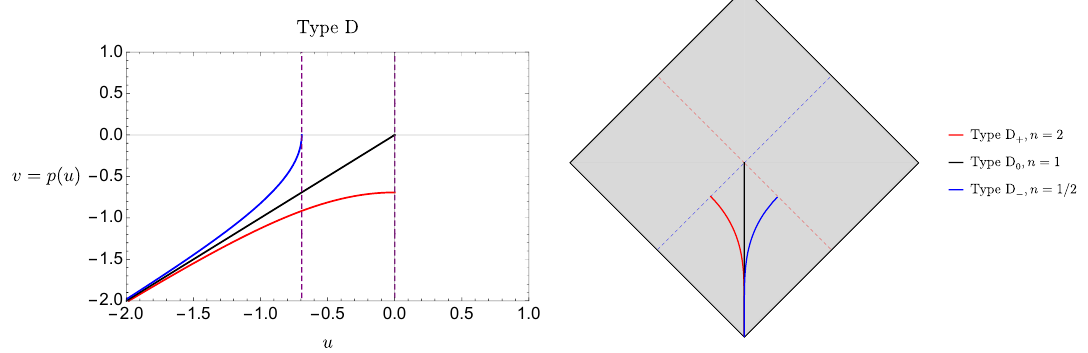
Figure 8 . Type D mirrors. The three types D + , D 0 , and D − are distinguished in table 3. Left: corresponding conformal mapping functions p ( u ) . The simple type D represents a part of the 0 D static case, and the functions p ( u ) for D are taken as defined in eqs. (4.26) and (4.31) with n = 2 ± D and n = 1 , respectively, see also table 3. Right: corresponding trajectories of moving mirrors in a 2 Penrose